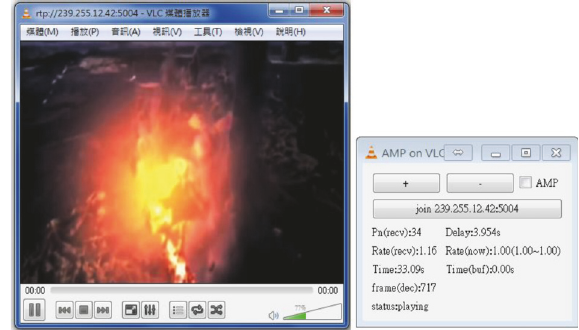
Figure 6: VLC media player and Lua program.